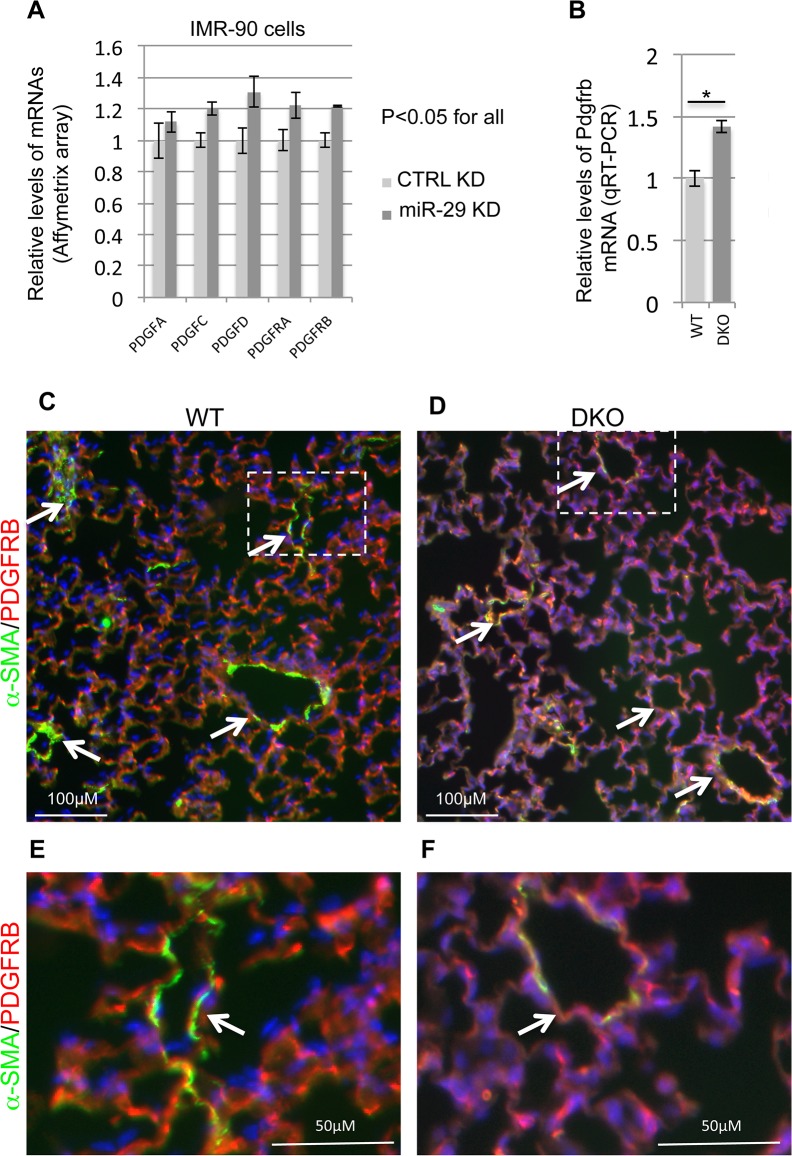
Upregulation of components of PDGF pathway in both miR-29 knockdown cells and miR-29 null lungs.
(A) Affymetrix array data of components of PDGF signaling pathway in miR-29 knockdown cells (n = 3). (B) qRT-PCR of Pdgfrb mRNA in lungs of wild type and DKO mice (n = 3). (C&D) Double IF staining of PDGFRB (red) and α-SMA (green) in WT control and miR-29 DKO lungs. (E&F) are enlarged images of areas highlighted by white dashed lines of C and D. Reduced vasculature α-SMA staining (green) is associated with increased PDGFRB staining (white arrowheads) in cells associated with vessel walls in DKO lungs (D&F). Images are representative of four littermate-matched WT/DKO pairs. Data are mean ± SEM; Student’s t test, * P<0.05.